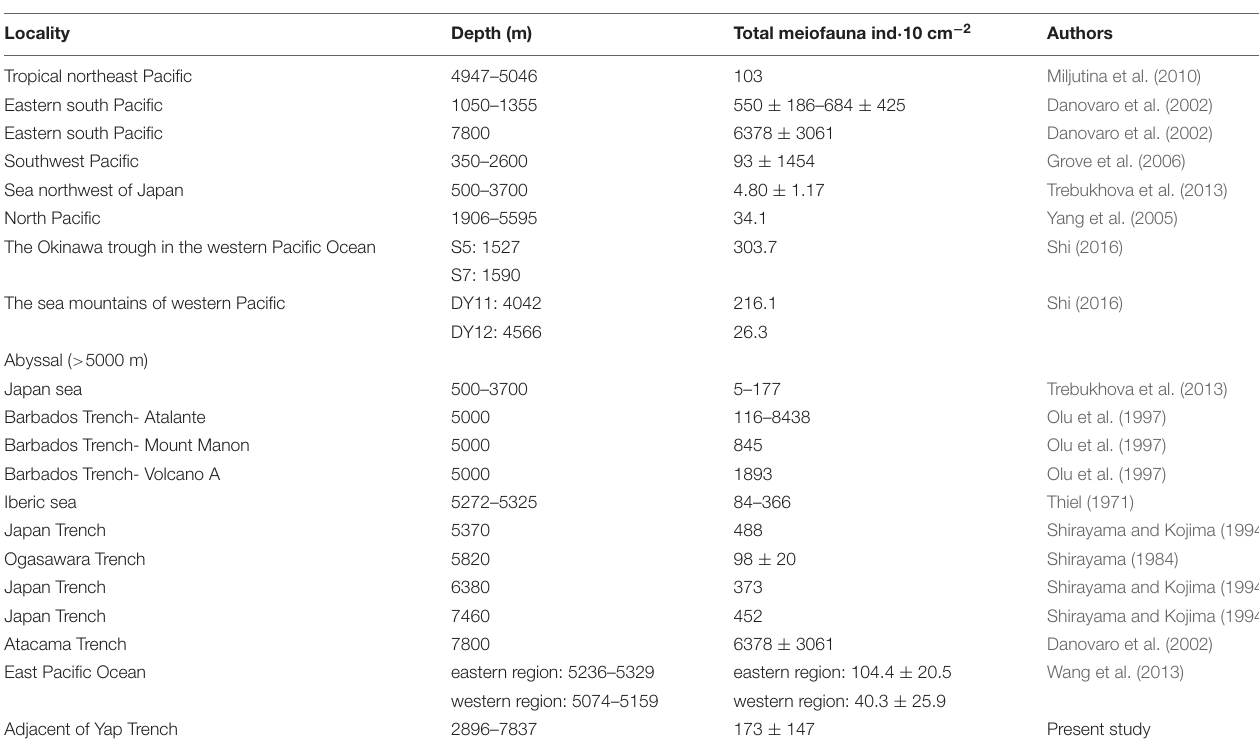
FIGURE 6 | Distribution pattern of meiofaunal abundance along with water depth. TABLE 6 | Comparison of meiofauna studies in the Western Pacific Ocean and other